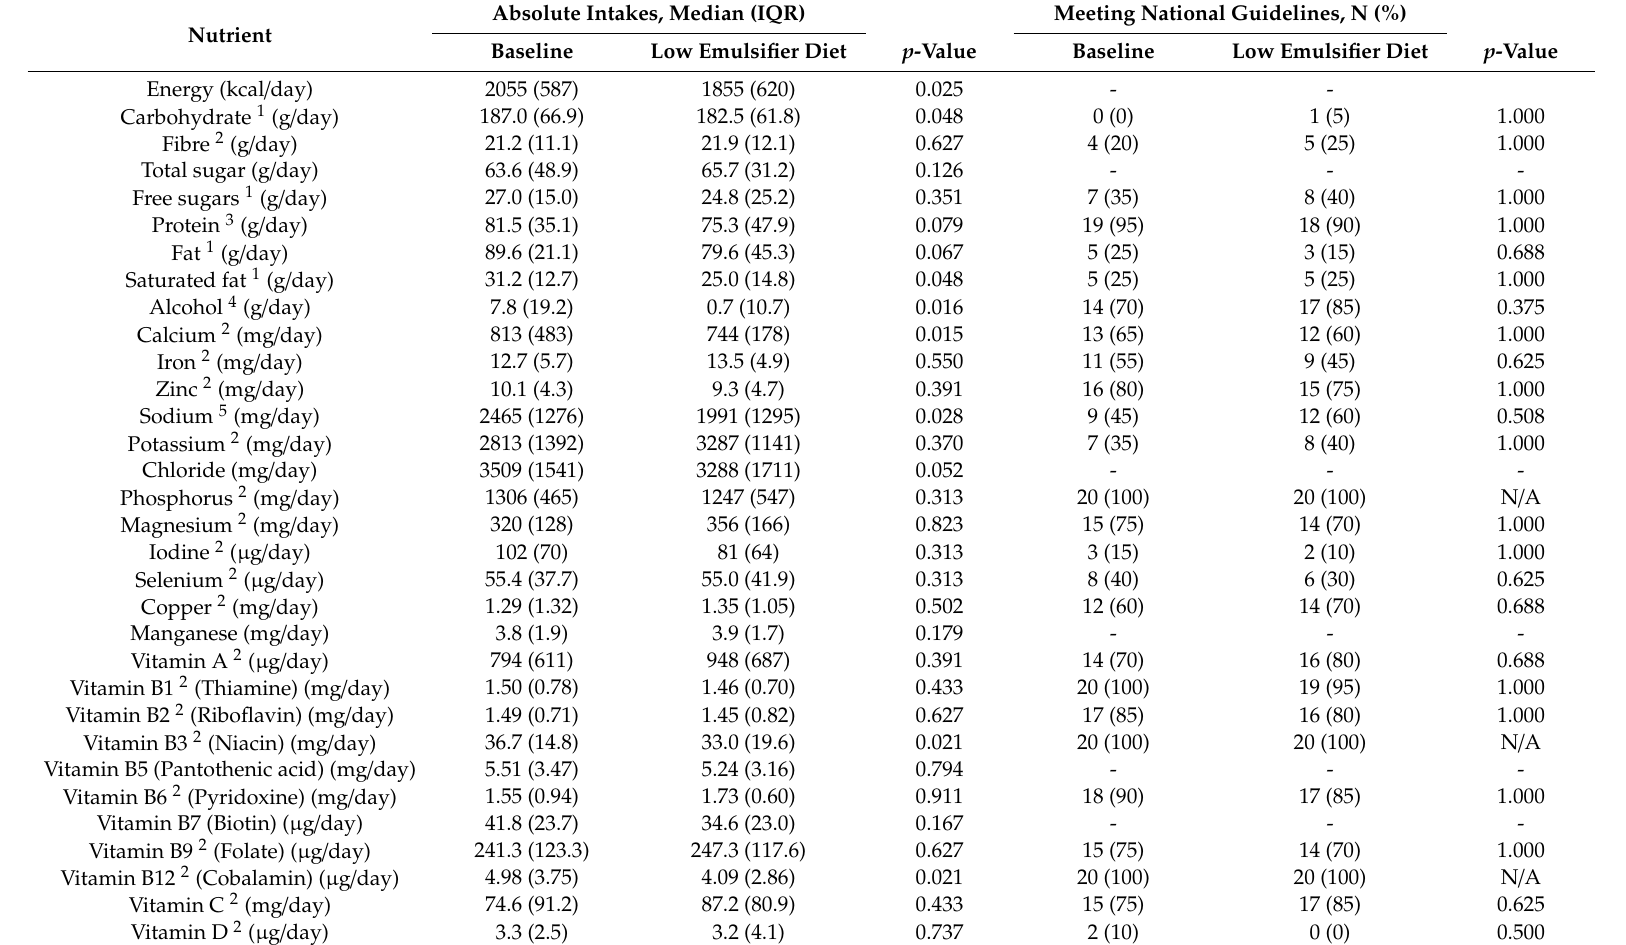
Table 3. Nutrient intakes at baseline and following the low emulsifier diet in 20 people with stable Crohn’s